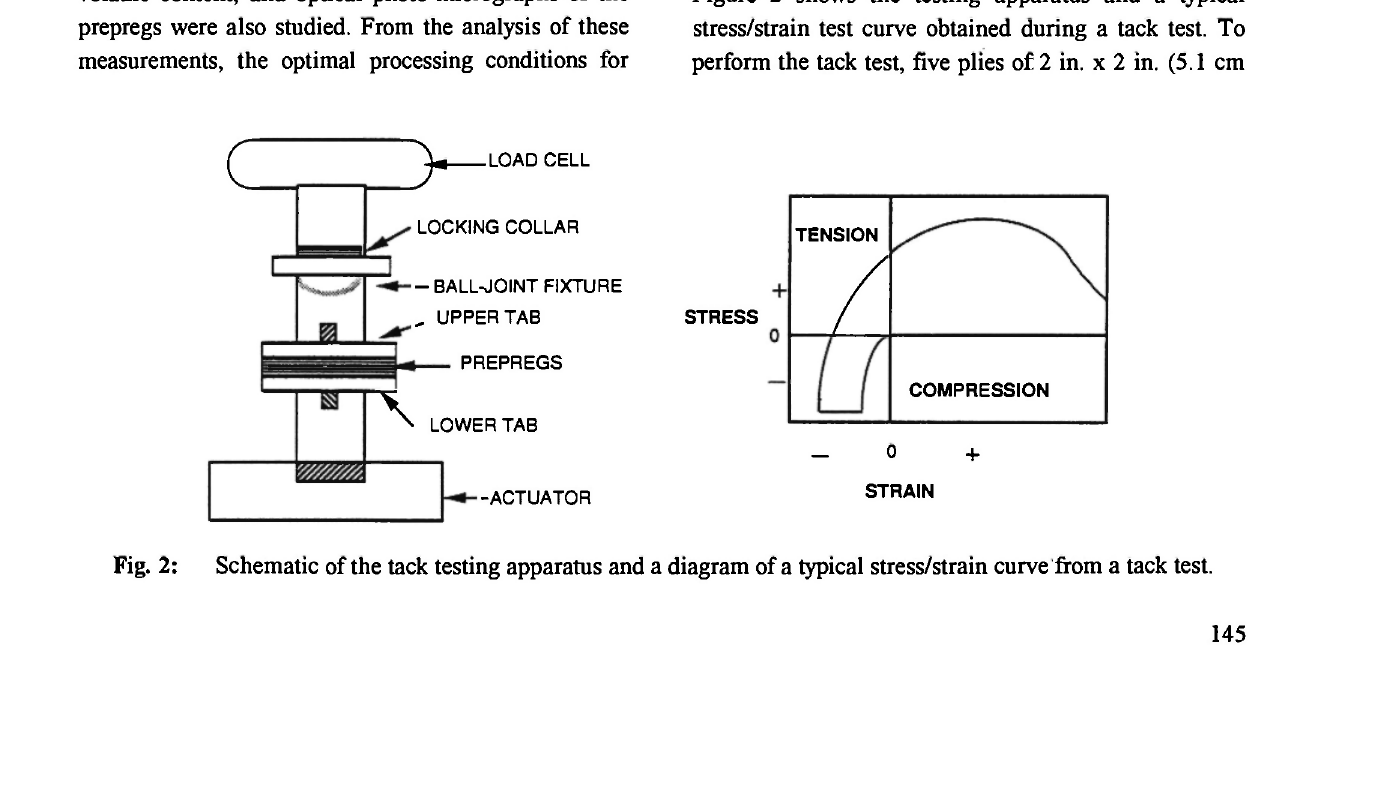
Fig. 2: Schematic of the tack testing apparatus and a diagram of a typical stress/strain curve from a tack